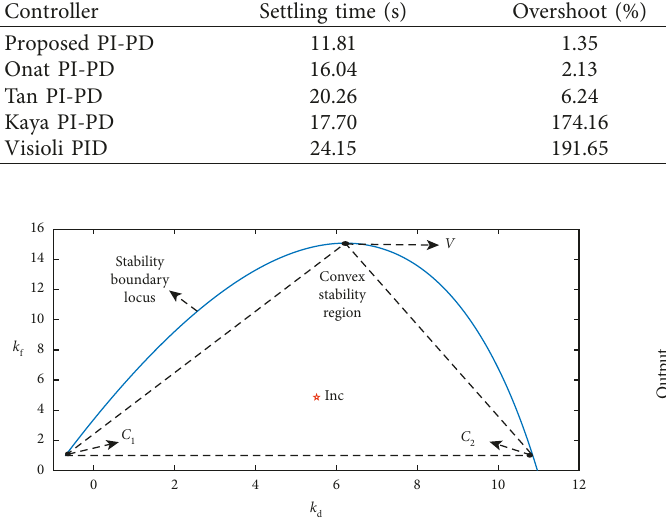
Figure 5: Convex stability region and incenter of PD controller in example B.